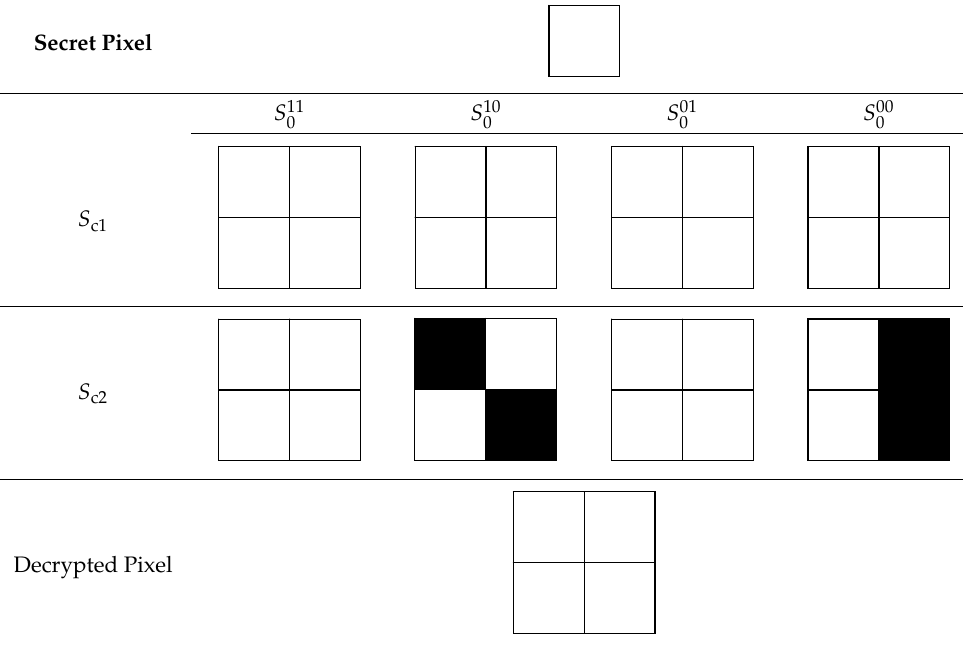
Table 1. The (2,2)-EVCS encryption and decryption example for a white pixel.